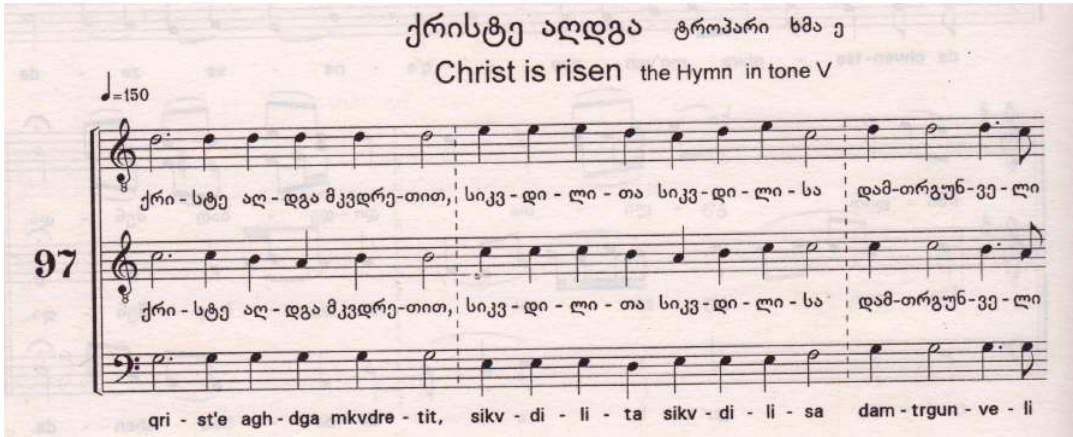
Figure 5. Paschal Troparion; Svan variant.